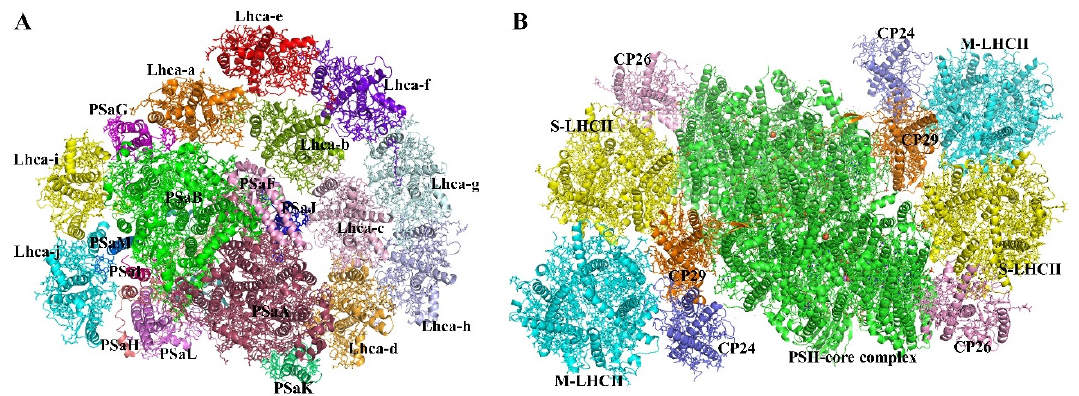
Figure 2. Structure of the PSI–LHCI and PSII–LHCII super-complex. ( A ) cryo-EM maps of super-complexes with PSI and LHCI from Bryopsis corticulans . (resolution 3.49 Å). PSaA, raspberry; PSaB, green; PSaF, pink; PSaG, magenta; PSaH, salmon; PSaI, hot pink; PSaJ, blue; PSaK, lime green; PSaL, violet; PSaM, marine; Lhca-a, orange; Lhca-b, split pea; Lhca-c, light pink; Lhca-d, bright orange; Lhca-e, red; Lhca-f, purple blue; Lhca-g, pale cyan; Lhca-h, light blue; Lhca-i, yellow; Lhca-j, cyan. ( B ) cryo-EM maps of super-complexes with PSII core and LHCII from Pisum sativum . (resolution 2.70 Å). M–LHCII, cyan; S–LHCII, yellow; CP24, slate; CP29, orange; CP26, light pink; PSII core complex,